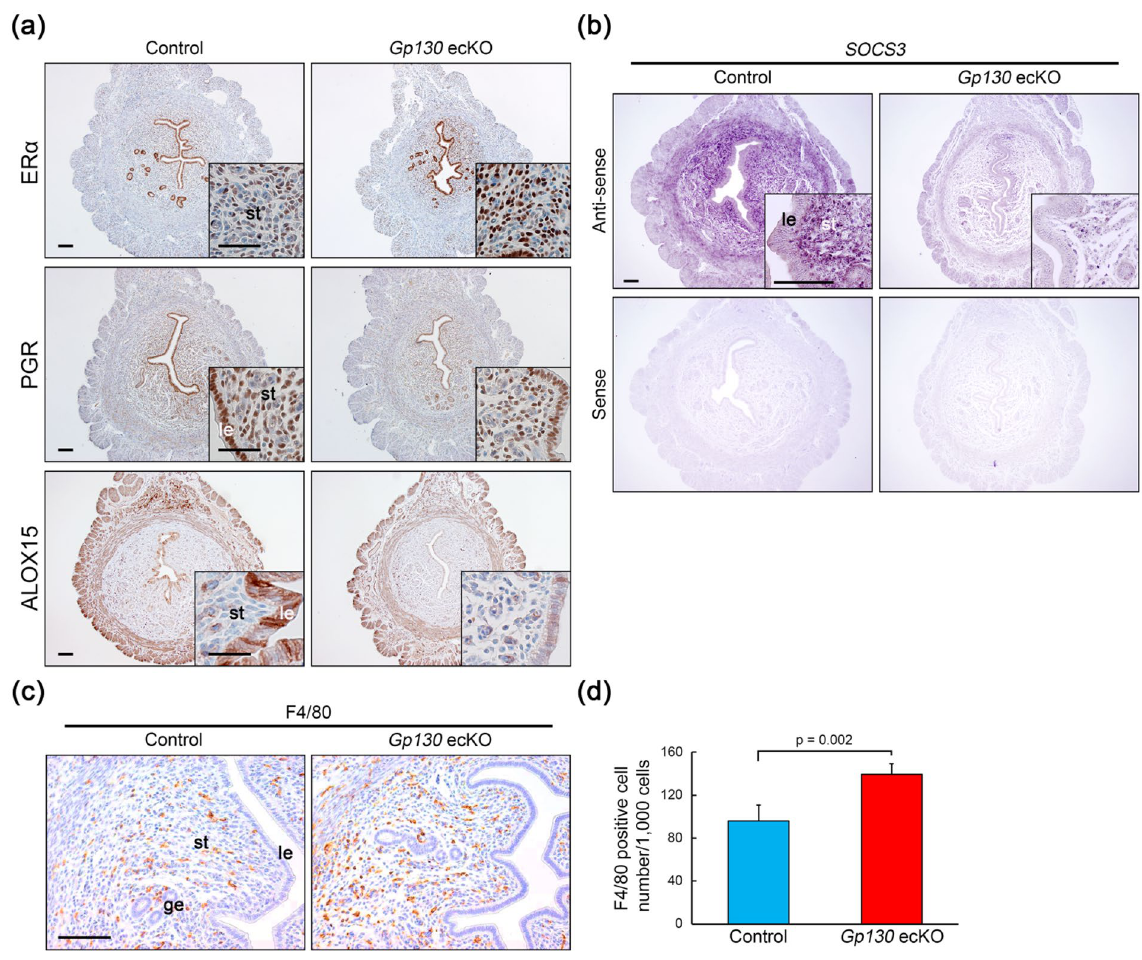
Figure 5. Immunostaining for estrogen- and progesterone-related factors in the control and Gp130 ecKO uteri. ( a ) Stromal ERα expression is increased in Gp130 ecKO uteri compared to the control at D4 (1600 h). PGR expression is comparable, but ALOX15 expression, downstream of PGR, is dramatically decreased in the uterine epithelium from Gp130 ecKO compared to the control. ( b ) Socs3 mRNA expression (dark purple in anti-sense probe) by ISH on D4 (1600 h). The sense probe shows a background signal. ( c , d ) The number of cells positive for F4/80, a marker of macrophages, is significantly increased in Gp130 ecKO stroma compared to the control at D4. Scale bars: ( a ) 100 µm (with lower magnification) and 50 µm (with higher magnification), ( b ) 100 µm, and ( c ) 50 µm. le luminal epithelium, ge glandular epithelium, st of day 4 8,11 . On the other hand, LIFR and Gp130 co-localize in the luminal epithelium at midnight of day 4 6 . In particular, Gp130 is dominantly expressed in the glandular epithelium but not in the luminal epithelium at the moment when the glandular LIF is expressed (Fig. 1) 12 . Phosphorylation of STAT3 (pSTAT3) in the luminal epithelium was found at 1600 h of day 4 in the control, but it was absent in Gp130 ecKO (Fig. 3d), suggesting that an undetectable level of Gp130 in the luminal epithelium may act as a receptor complex, or that LIF trans- duces signals by binding to a receptor complex other than the LIFR/Gp130 heterodimer, including low-affinity LIFR 38,39 . The observation that pSTAT3 was detectable in the luminal epithelium from wildtype female at day 1 of pregnancy, when the Gp130 is low, might support these possibilities (Supplementary Fig. 6). The present study demonstrated that the absence of uterine epithelial Gp130 leads to infertility for a reason different from that shown in the uterine-specific Gp130 knockout 8 . Our results indicated that Gp130 ecKO cannot support embryo attachment due to the failure of epithelial remodeling caused by the dysregulation of hormone- responsive factors. In fact, stromal ERα was substantially increased and P4-target epithelial genes, including Alox15 and Areg , were dramatically decreased in Gp130 ecKO (Fig. 4b). AlOX15 oxidizes polyunsaturated fatty acids to generate bioactive lipid metabolites and may play an important role in inflammatory response during